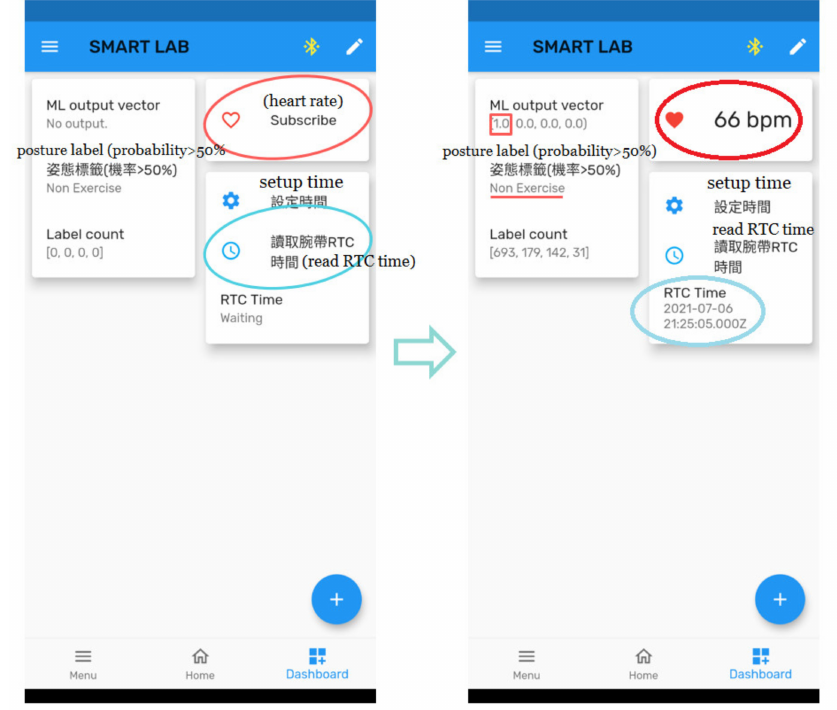
Figure 15. Dashboard to subscribe heart rate data. Three sets of weight training were performed by one participant in each of the three weight exercises: bicep, side planks, and shoulder press. Table 6 shows an